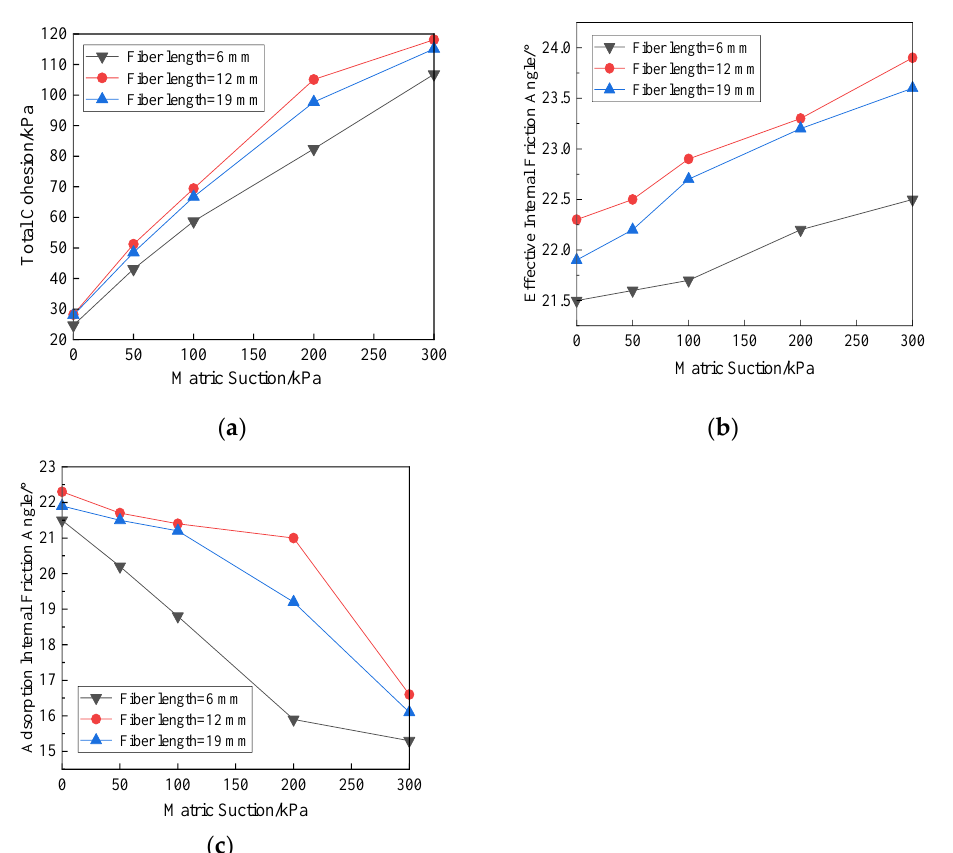
Figure 8. Influence of matric suction on shear strength parameters. ( a ) Effects of the matric suction on the total cohesion force, ( b ) effects of matric suction on the effective internal friction angle, ( c ) effects of the matric suction on the adsorption internal friction angle.